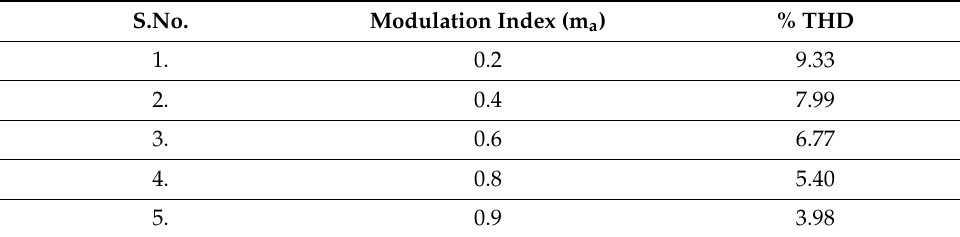
Table 11. THD analysis of qZS-CHBMLI at different value of m a . S .No.